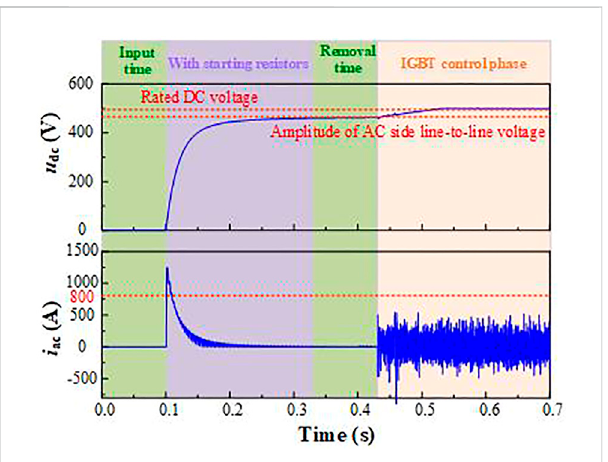
FIGURE 10 Simulationresultsof u dc and i ac usingconventionalstart-upmethod.